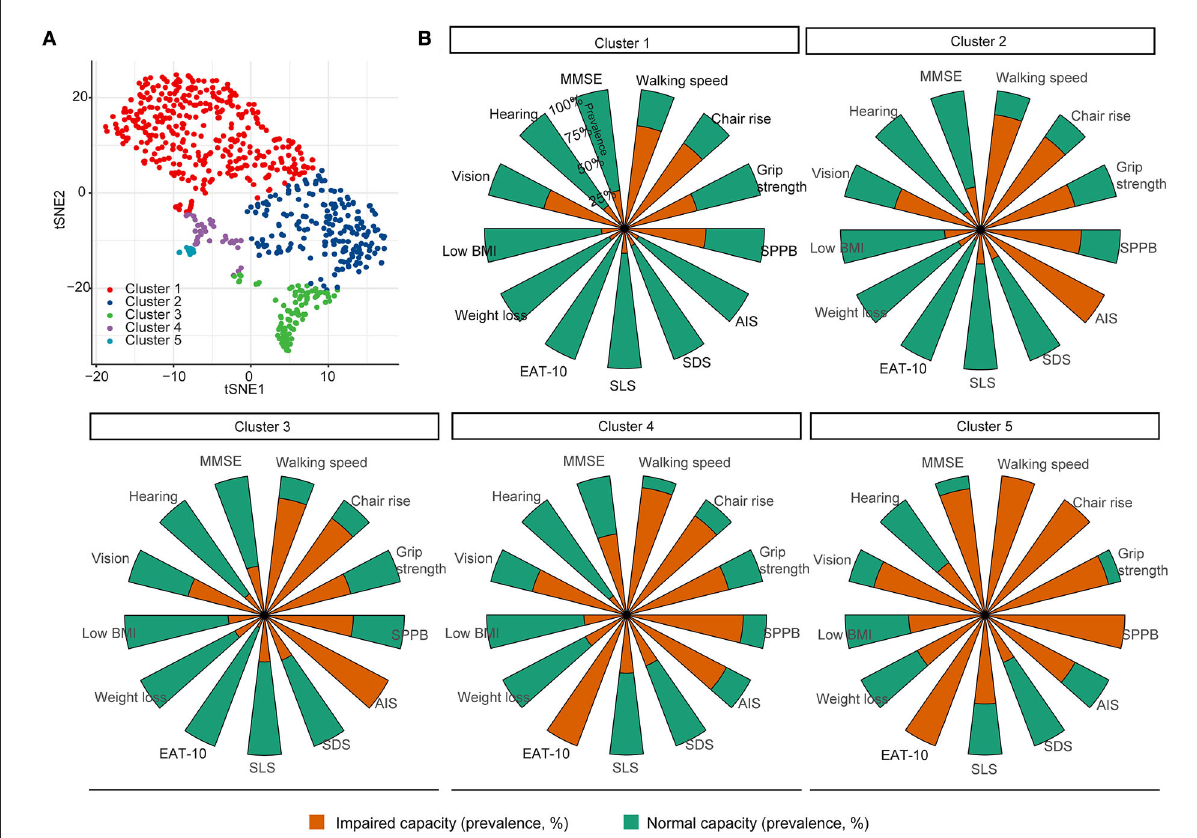
FIGURE2 Unsupervised classification of older inpatients based on domains of intrinsic capacity. (A) K-means and t-SNE were used to group and visualize the patients, respectively, based on 13 measurements of the intrinsic capacity domains. (B) Thirteen measurements depicted the characteristics of each cluster, where the a stacked bar graph showed the prevalence of a deficit. MMSE, Mini-Mental State Examination; SPPB, Short Physical Performance Battery; AIS, Athens Insomnia Scale; SDS, self-reported depressive symptoms; SLS, self-reported life satisfaction; Eat-10, 10 Items for Swallowing Assessment.